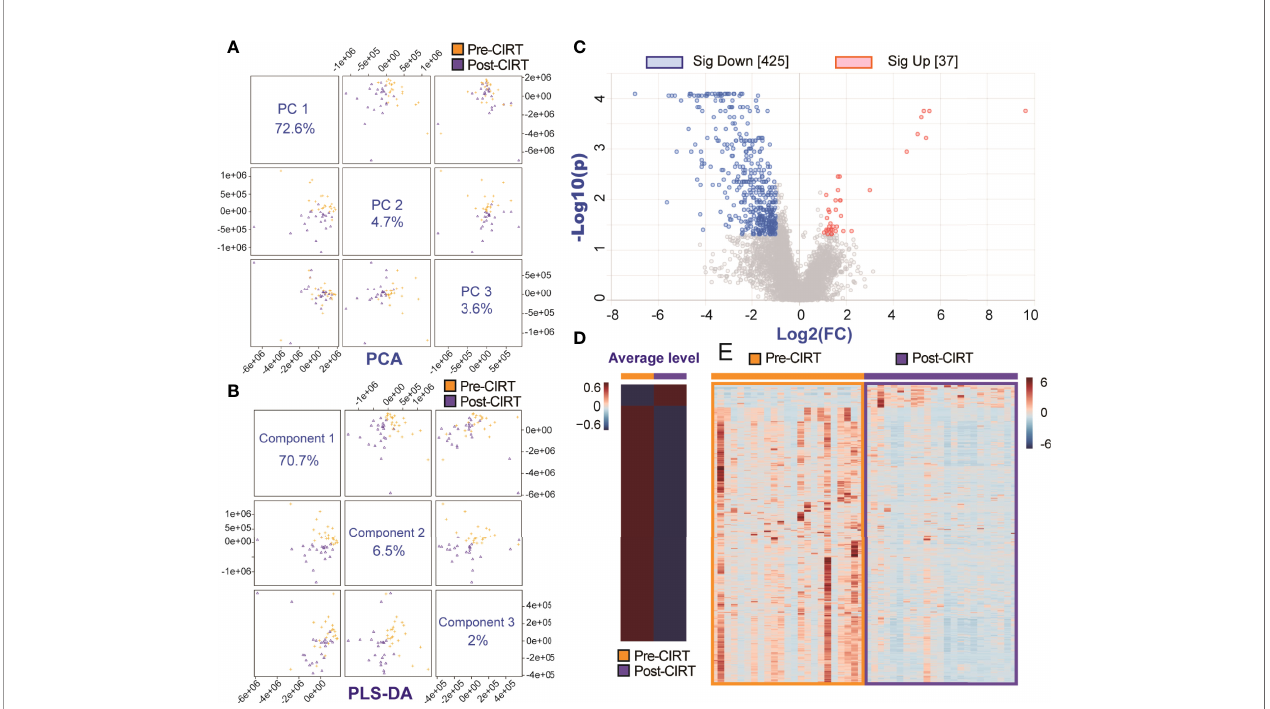
FIGURE 3 | The metabolic inhibition effect of CIRT on PCa. The PCA (A) and PLS-DA (B) analysis of all pre-CIRT and post-CIRT samples from the both SIB group and non-SIB group. (C) The volcano plot of pre-CIRT and post-CIRT samples from all PCa patients in both groups. Blue and red dots represent signi fi cantly down- regulated and up-regulated metabolites, respectively (FDR<0.05, FC>2). (D) The heat map showed the average level of signi fi cantly altered metabolites in pre-CIRT and post-CIRT samples. (E) The heat map showed the detailed level of signi fi cantly altered metabolites in each pre-CIRT and post-CIRT